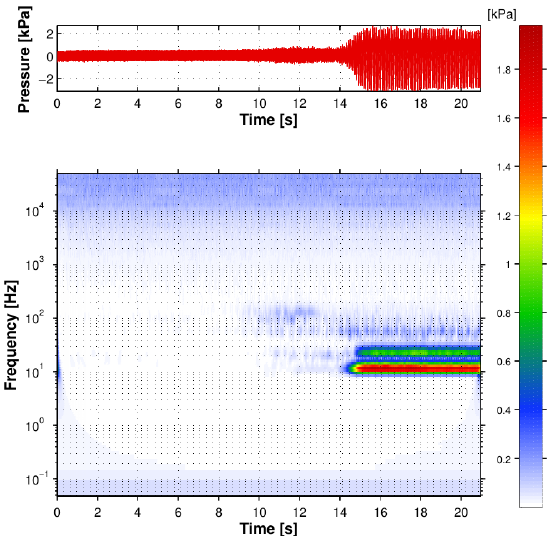
Figure 5: Pressure signal at the gauge p s − in and its CWT